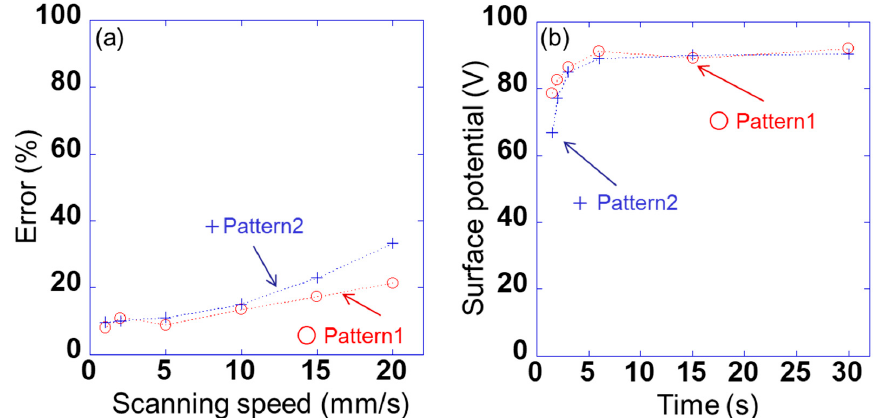
Figure 7. ( a ) Relationship between detected errors V err and scanning speed of sensor s 10 in pattern 1 (AV b1 = +100 V and AV b2 = 0 V) and pattern 2 (AV b1 = +100 V and AV b2 = − 100 V) and ( b ) the rela- tionship between the surface potential detected by sensor s 10 and the scanning time in patterns 1 and